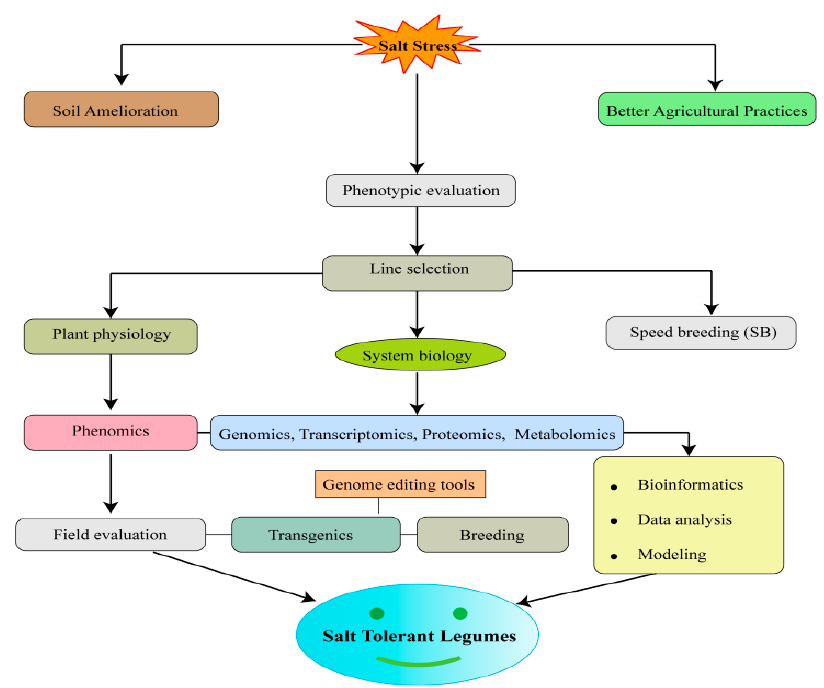
Figure 5. Schematic representation of approaches for developing of salt tolerant legumes. The integration of “omics” approaches along with advance genome editing (GE) tools and agronomic approaches can improve salt tolerance in legumes.